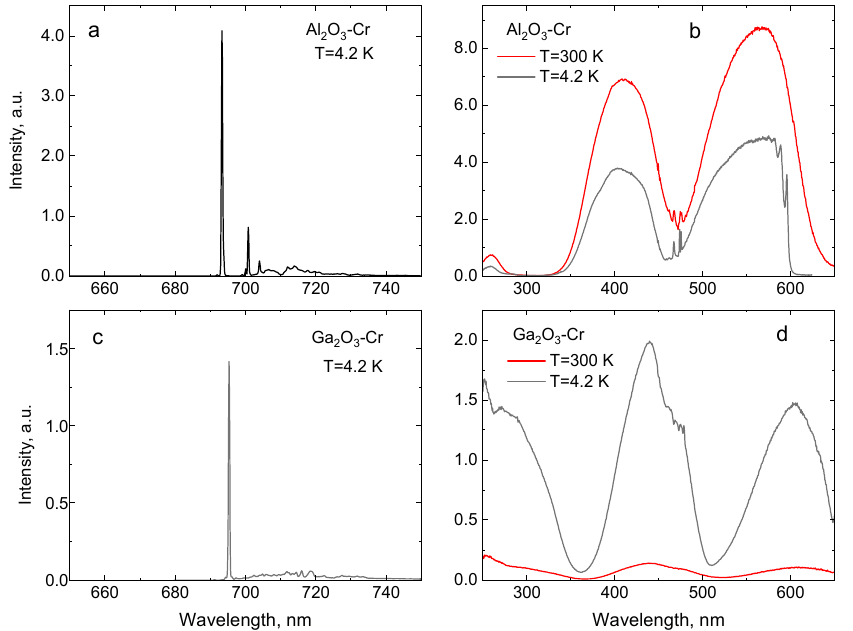
Figure 1. Luminescence ( a , c ) and luminescence excitation spectra ( b , d ) of Al 2 O 3 -Cr and Ga 2 O 3 -Cr crystals.